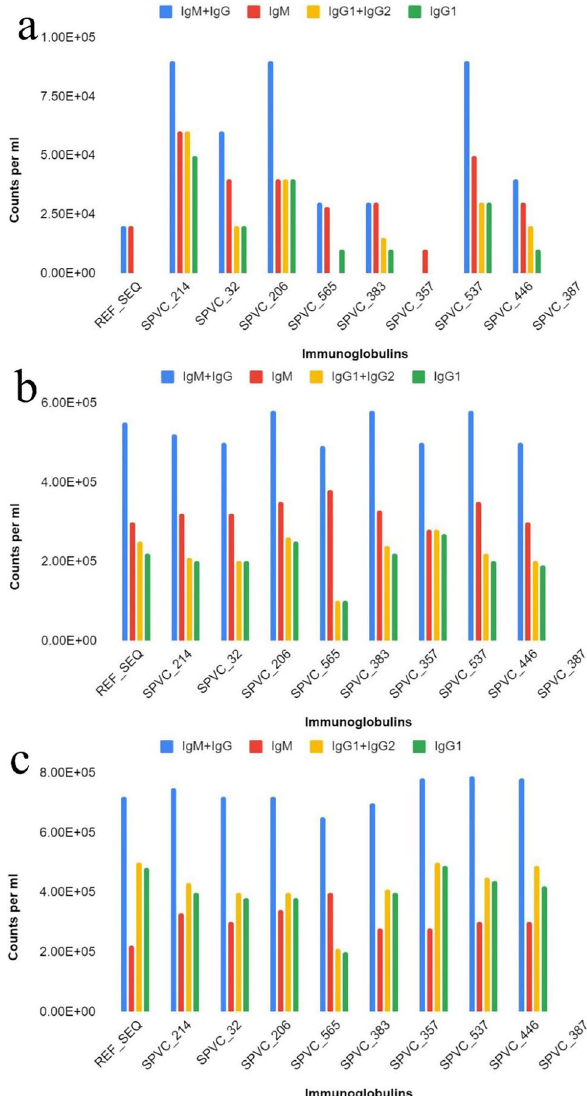
Figure 5. Immunoglobulin counts of MEBP variants (without adjuvants + HIS-tag) after ( a ) 1st dose, ( b ) 2nd dose, ( c ) 3rd dose (X axis—vaccine constructs, Y axis—counts per